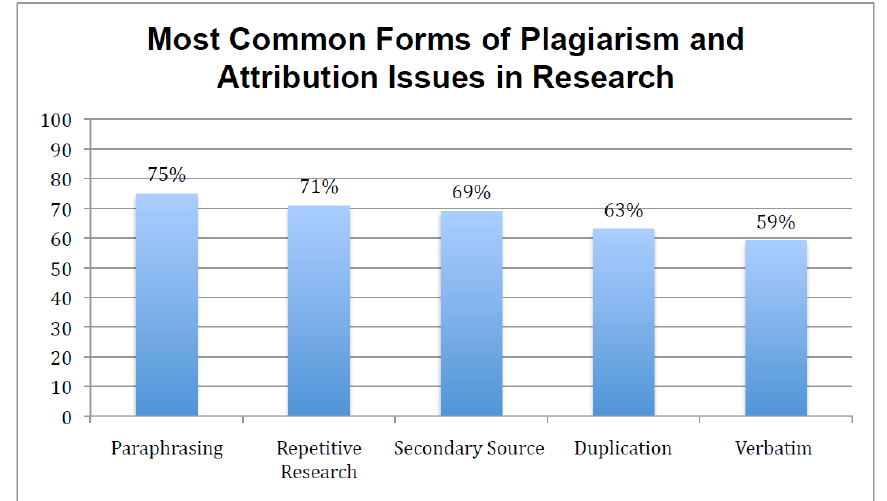
Fig. 1. According to iThenticate survey respondents (Staff,